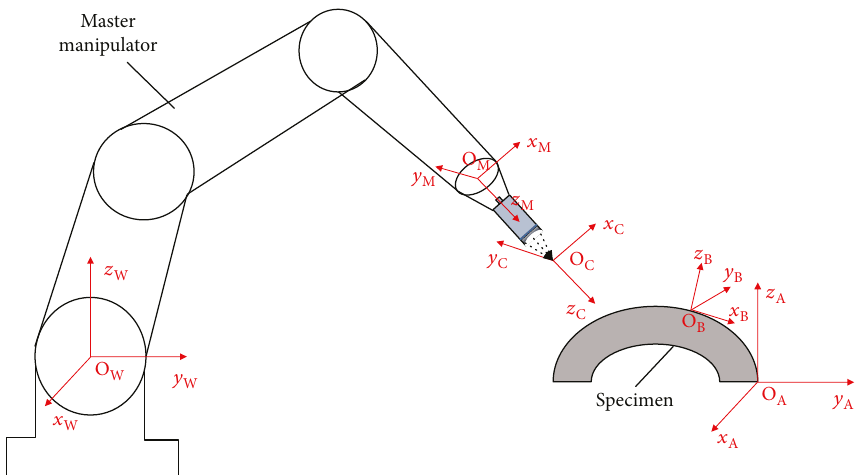
Figure 6: De fi nition of the coordinate systems in the master